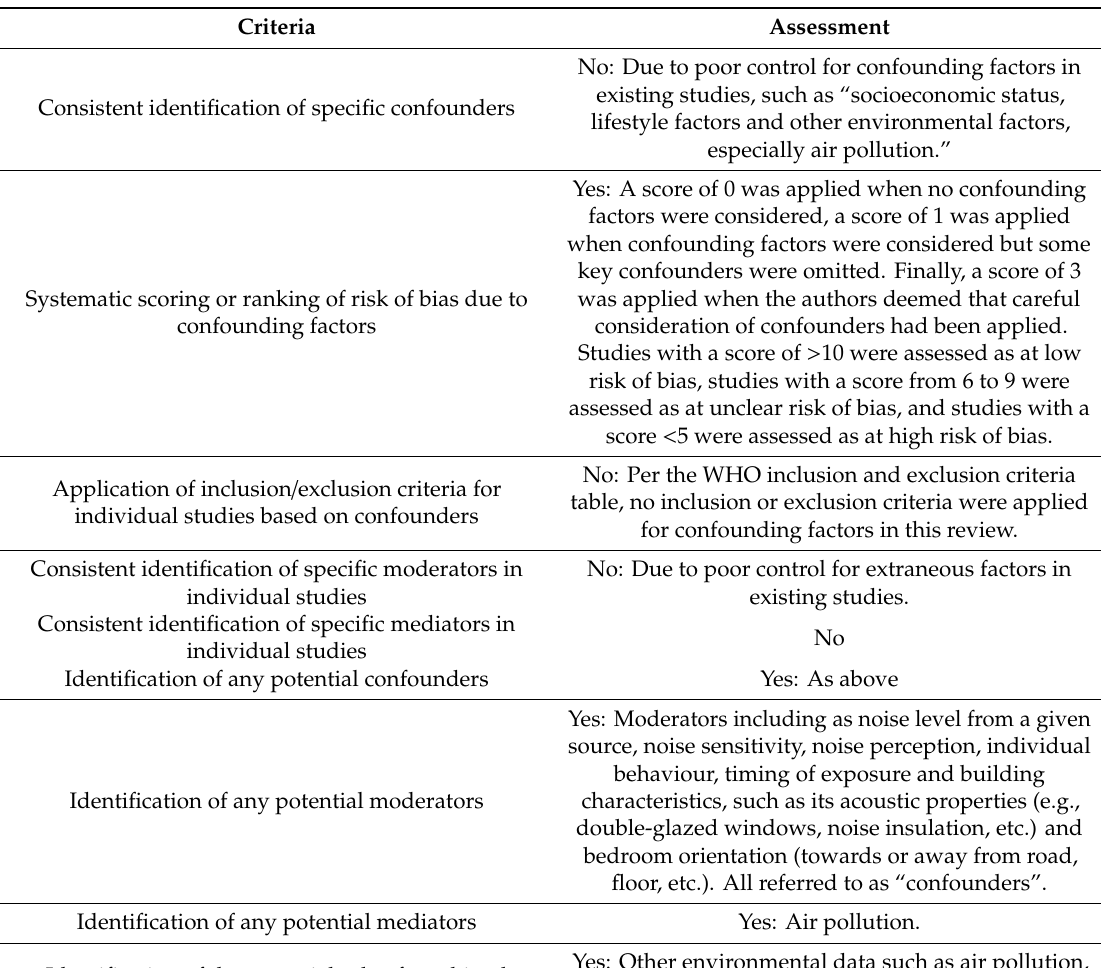
Table 5. Assessment for e ff ects on birth